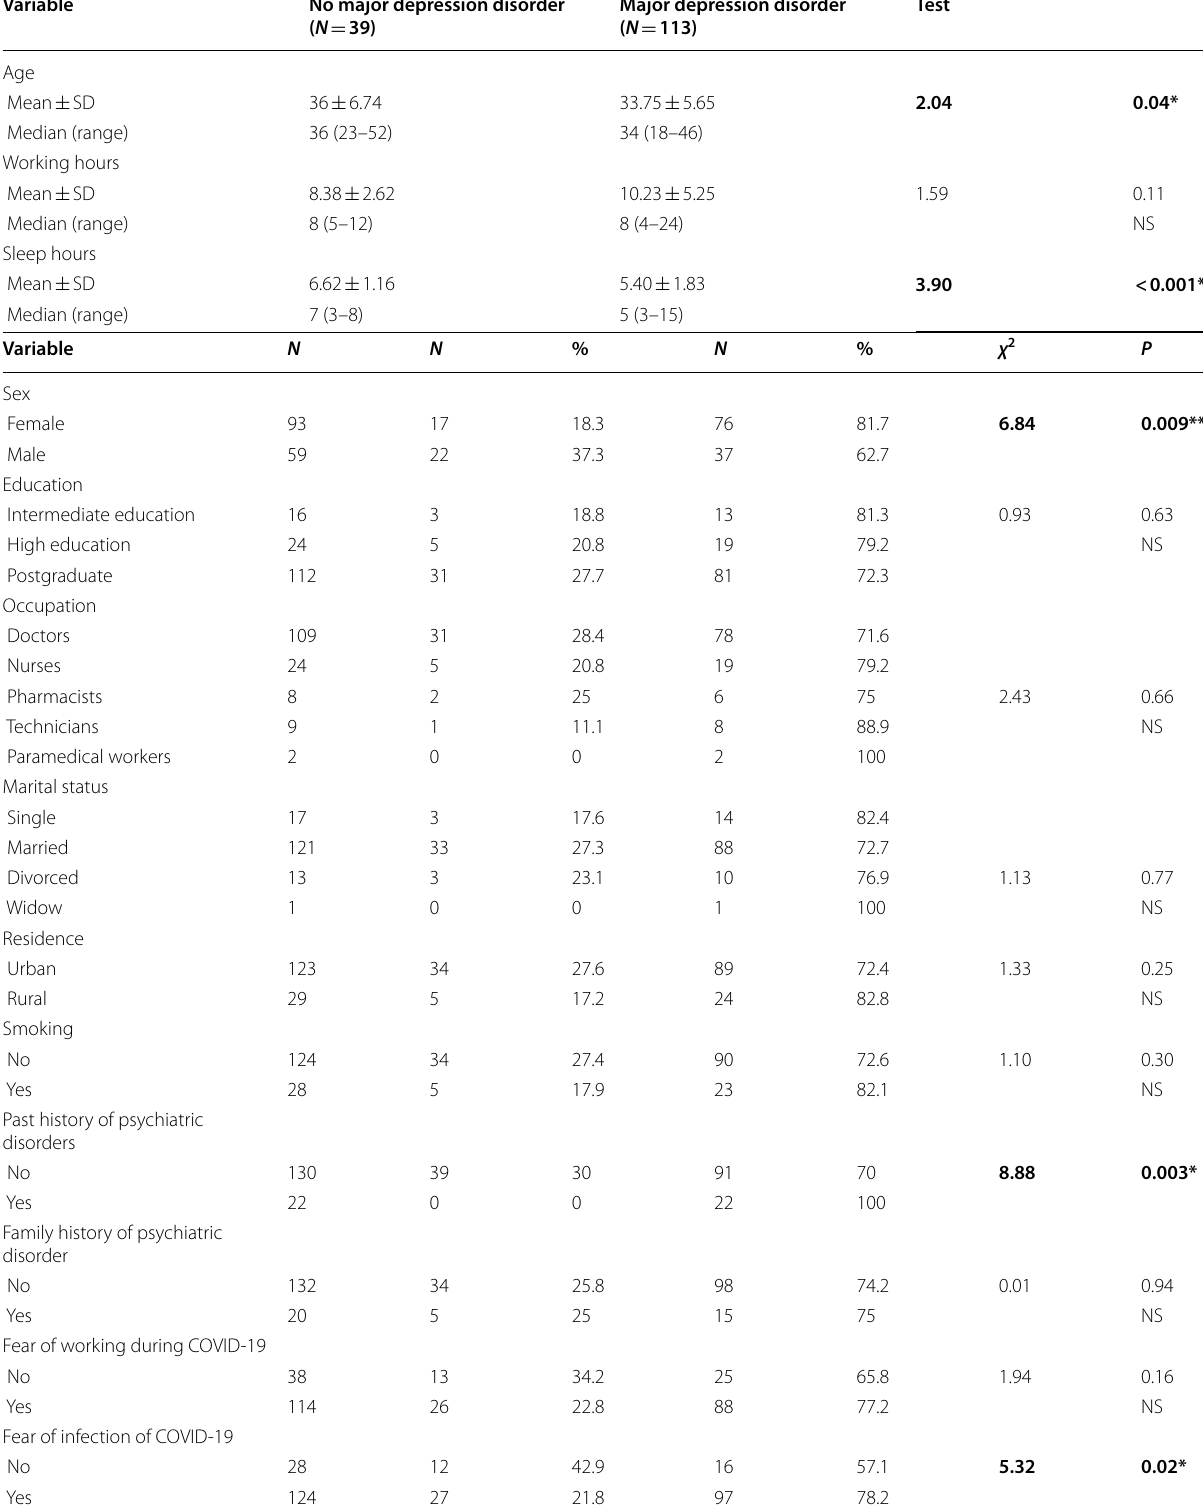
Table 3 Comparison between those who are not depressed versus those who are depressed according to SCID-1 evaluation